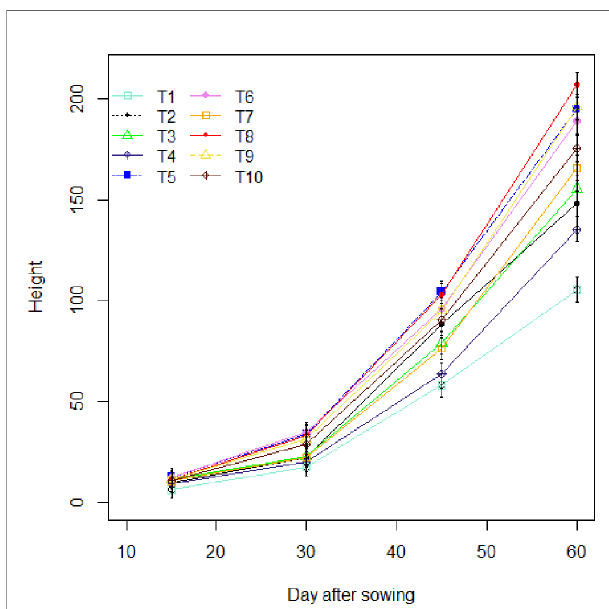
FIGURE 3 | Variation in diameter as a function of fi eld treatments. T1, Control; T2, Glomeraceae; T3, Acaulosporaceae; T4, 25% NPK + urea; T5, Glomeraceae + 25% NPK+ urea; T6, Acaulosporaceae + 25% NPK+ urea; T7, 50% NPK + urea; T8, Glomeraceae + 50% NPK+ urea; T9, Acaulosporaceae + 50% NPK+ urea; T10, 100% NPK+ urea